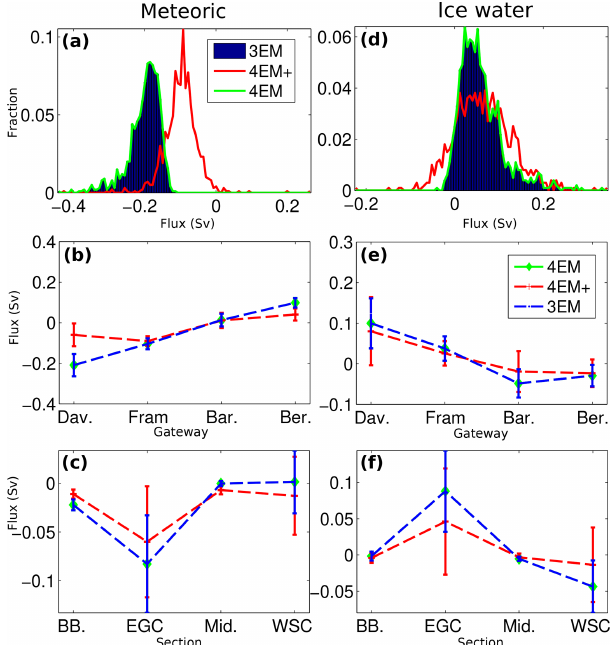
Figure 11. Meteoric and ice water volume fluxes. (a, d) Histograms of the total attributed volume fluxes (Sv) for all model schemes. (b, e) Mean volume fluxes (Sv ± standard deviation) for each gate- way. (c, f) Volume fluxes (Sv ± standard deviation) for the compo- nents of the Fram Strait (Belgica Bank, BB; East Greenland Cur- rent, EGC; mid-strait, Mid.; West Spitsbergen Current, WSC). The 3EM model is in blue, the 4EM model in green, and the 4EM+ model in red. Positive values indicate fluxes into the